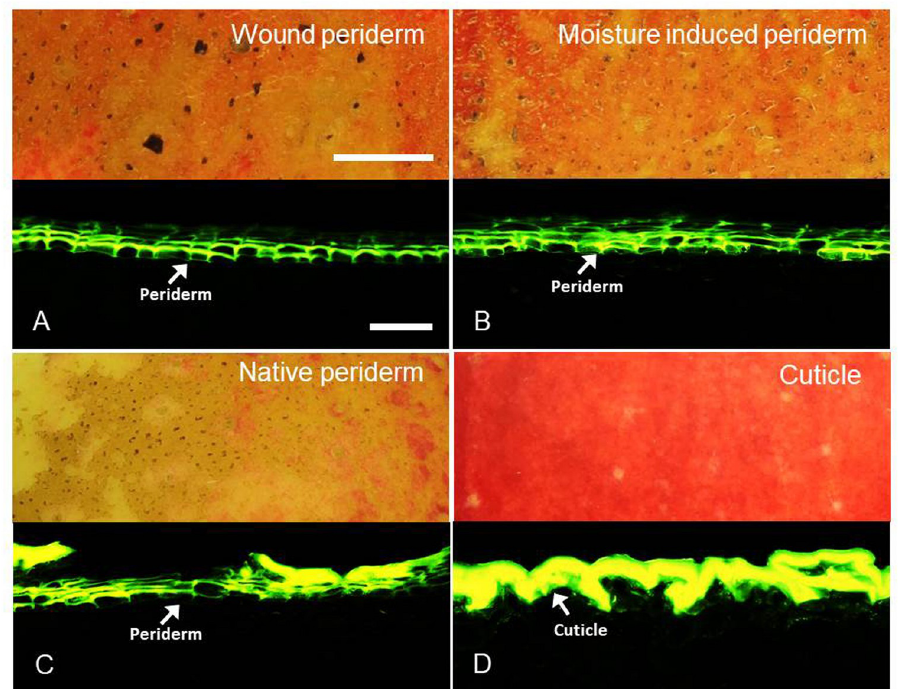
Fig 5. Cross-sections through patches of ‘Pinova’ apple fruit skin at the mature stage (156 days after full bloom (DAFB)) that had been wounded or exposed to surface moisture during early fruit development. Patches of fruit skin were wounded at 32 DAFB by abrading the cuticle using abrasive paper (‘Wound periderm’). For comparison, microcracks were induced by exposure of skin patches to surface moisture (‘Moisture-induced periderm’) from 31 to 43 DAFB. Non-treated naturally russeted surfaces (‘Native periderm’) and non-russeted surfaces served as control (‘Cuticle’). The cross-sections were stained with Fluorol Yellow. Scale bars in A 10 mm (upper) and 50 μ m (lower). Bars are representative for all bright field and all fluorescence images of the